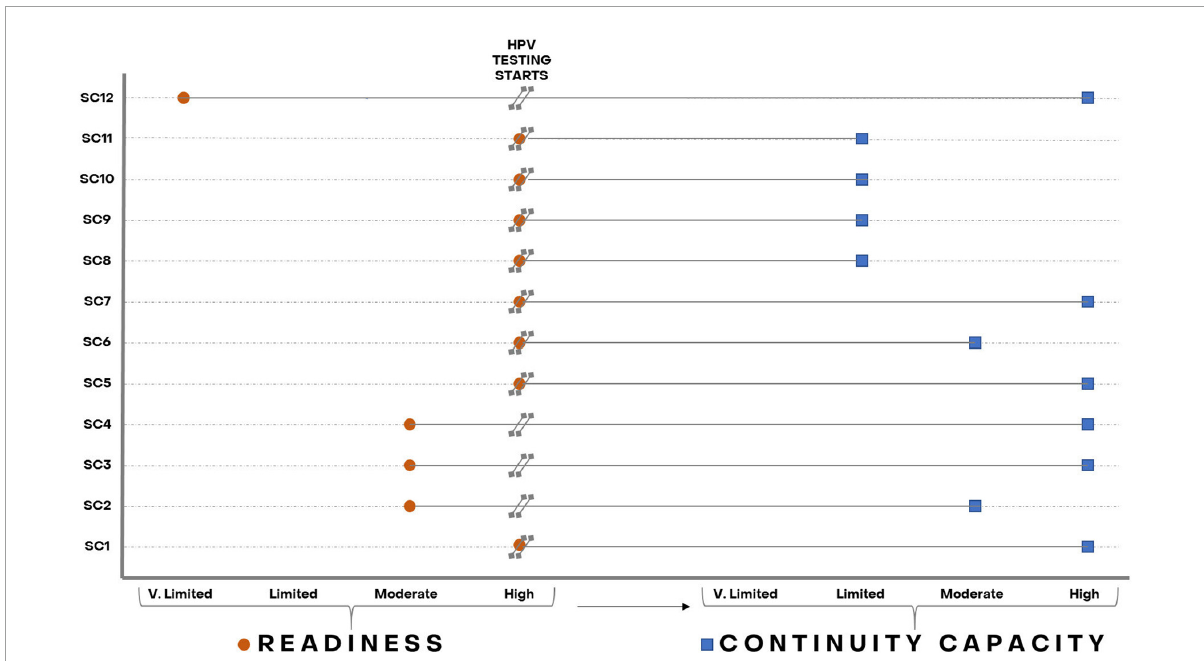
FIGURE3 Laboratories’ readiness and continuity capacity to perform HPV testing throughout recruitment in the ESTAMPA study. Orange circles represent laboratories’ readiness and blue squares laboratories’ continuity capacity as assessed from the start of HPV testing up to December 2021.